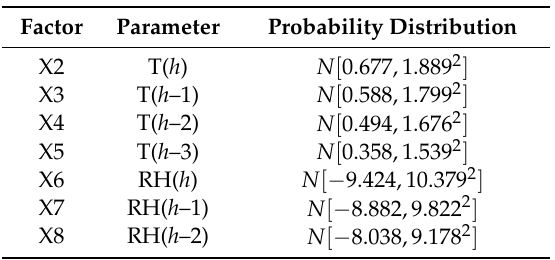
Table 4. The probability distribution of each input parameter.